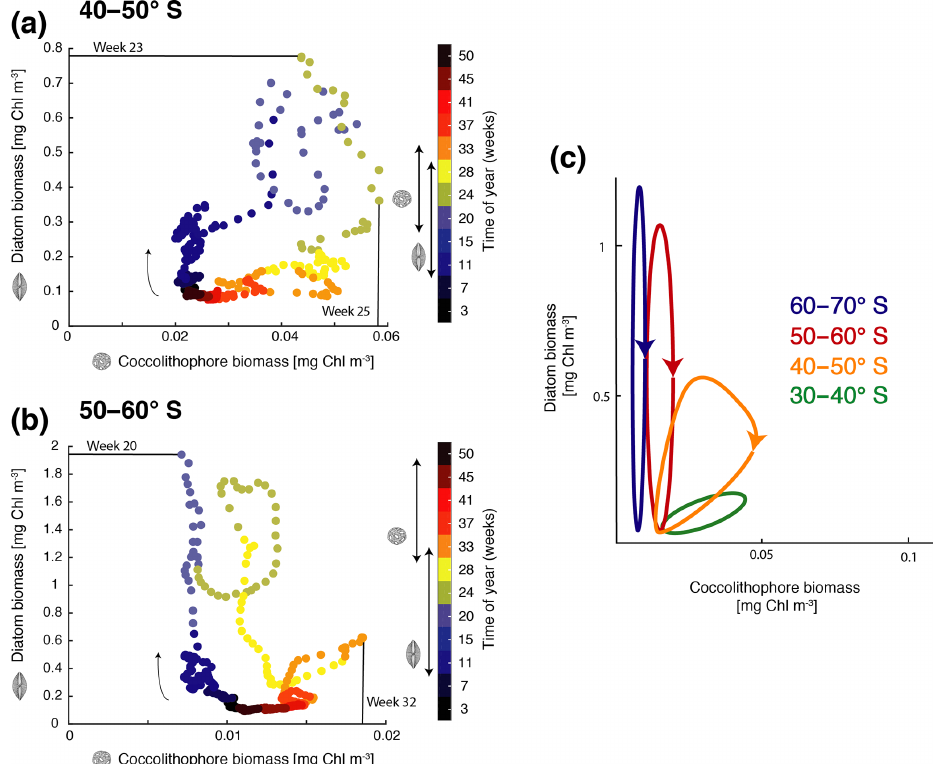
Figure 4. Phase diagram of daily surface diatom and coccolithophore chlorophyll biomass (mgChlm − 3 ) for (a) 40–50 ◦ S and (b) 50–60 ◦ S. The colors indicate the time of the year (given in weeks) and the arrow indicates the course of time. Bloom start, bloom end, and bloom duration are marked with arrows on the color bar showing time evolution from July–June for diatoms and coccolithophores, and bloom peak is drawn directly into the phase diagram. (c) Sketch of diatom and coccolithophore chlorophyll biomass evolution (mgChlm − 3 ) for the different latitudinal bands. Lowest biomass in bottom left; arrows indicate temporal evolution. For details on the definition of the bloom metrics, see the